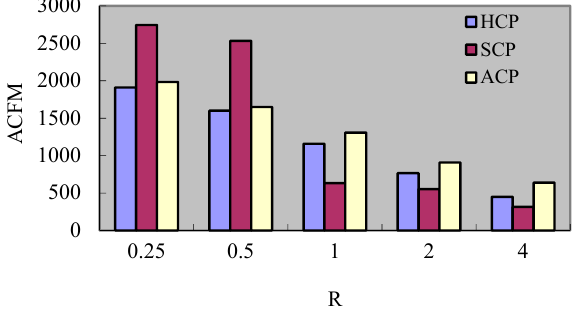
Figure 17. Impact of R on ACFM.